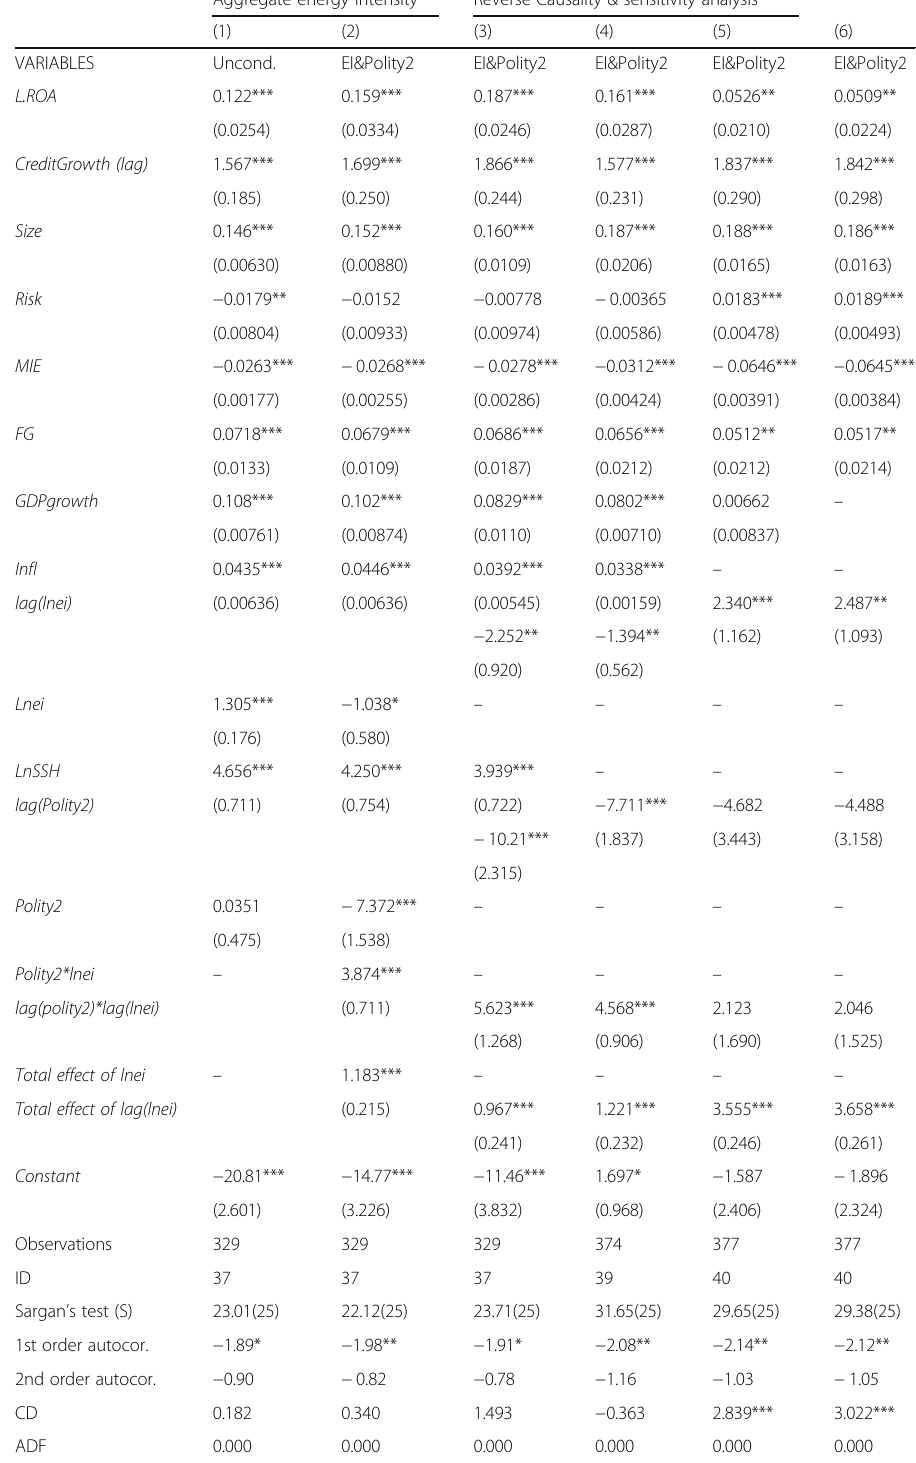
Table 4 Estimation